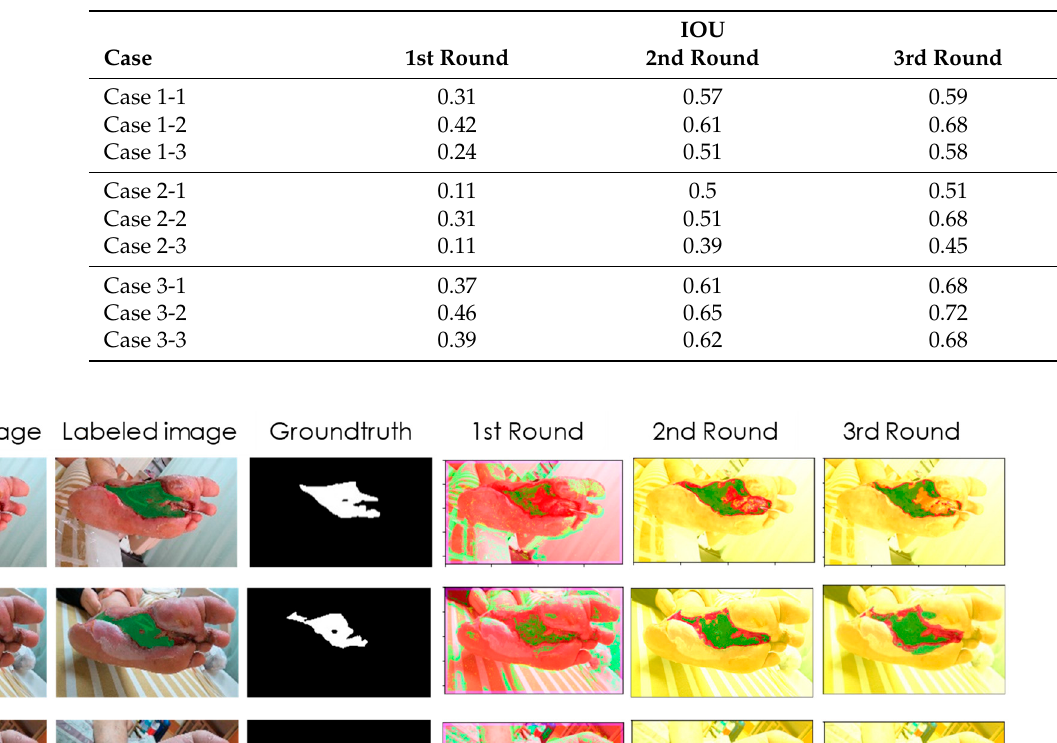
Table 2. Experimental results: the IOU rates compared to the groundtruth.